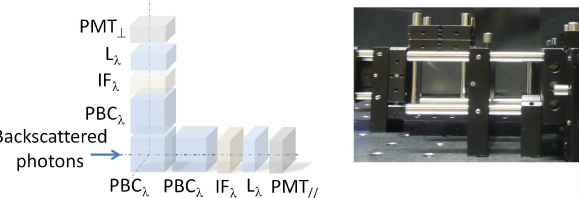
Fig. 1. Left: 3-D view of a Lyon λ polarization channel: each po- larization channel is composed of two polarization beamsplitter cubes (PBC), one interference filter (IF) and a collecting system (lens+photomultiplier tube PMT). Right: Photograph of the UV cross-polarized lidar polarization channel composed of two PBC. The subscripts // and ⊥ are defined with respect to the laser inci- dent polarization, respectively corresponding to the co- and cross- polarized polarization lidar